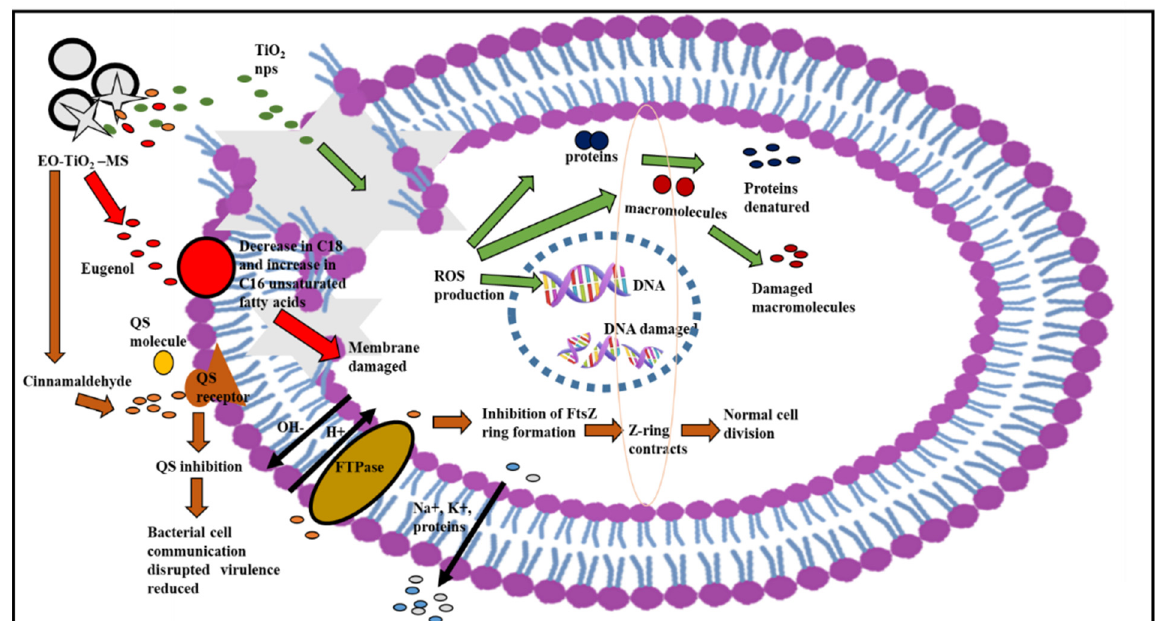
Figure 15. Proposed mechanism of antibacterial action of CI-TiO 2 -MS on S. aureus [68–70] .